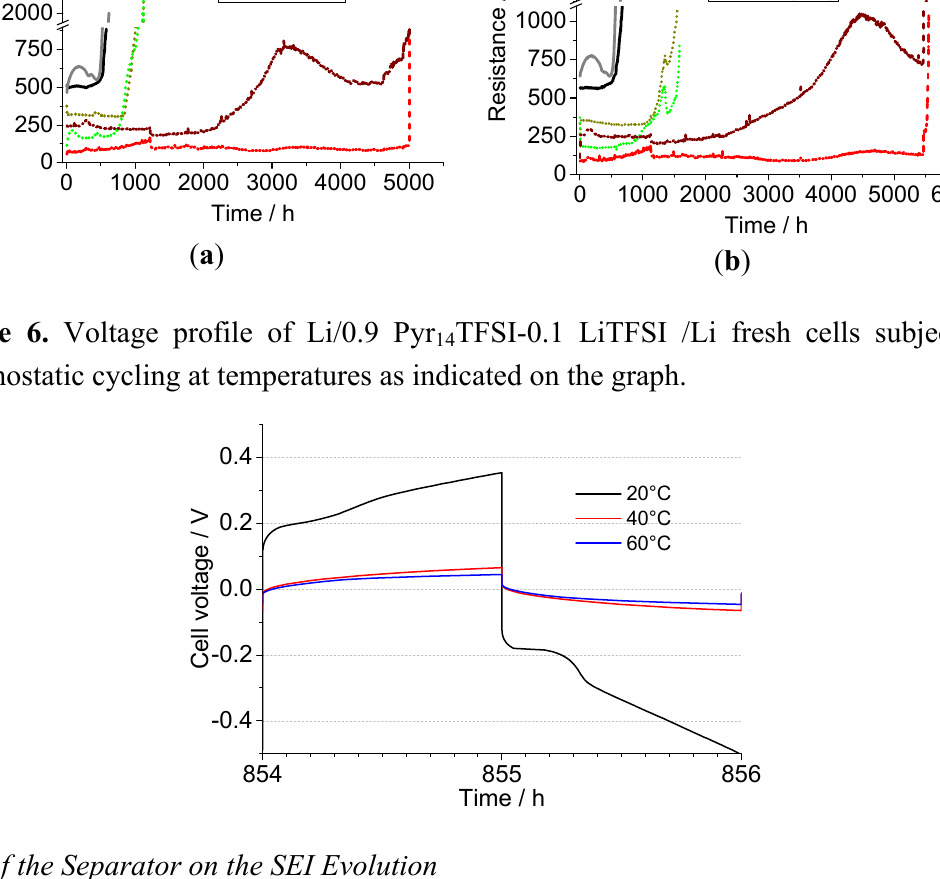
and equivalent series resistance (ESR) with cycling time for the Figure 5. Evolution of R pol set of ( a ) fresh cells and ( b ) thermally conditioned cells.